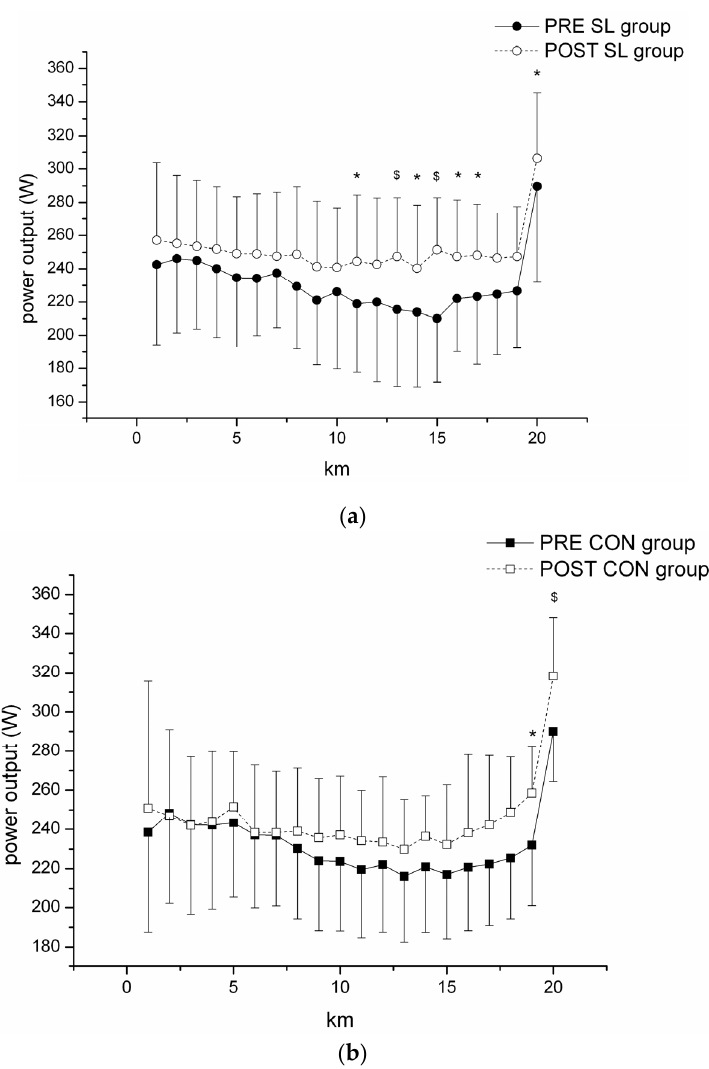
Figure 3. Pacing strategy (absolute change in power output per kilometer) during the 20 km cycling time ‐ trial in PRE and POST tests for ( a ) SL group; and ( b ) CON group. * Significantly different from PRE values, p < 0.05. $ Significantly different from PRE values, p < 0.01.